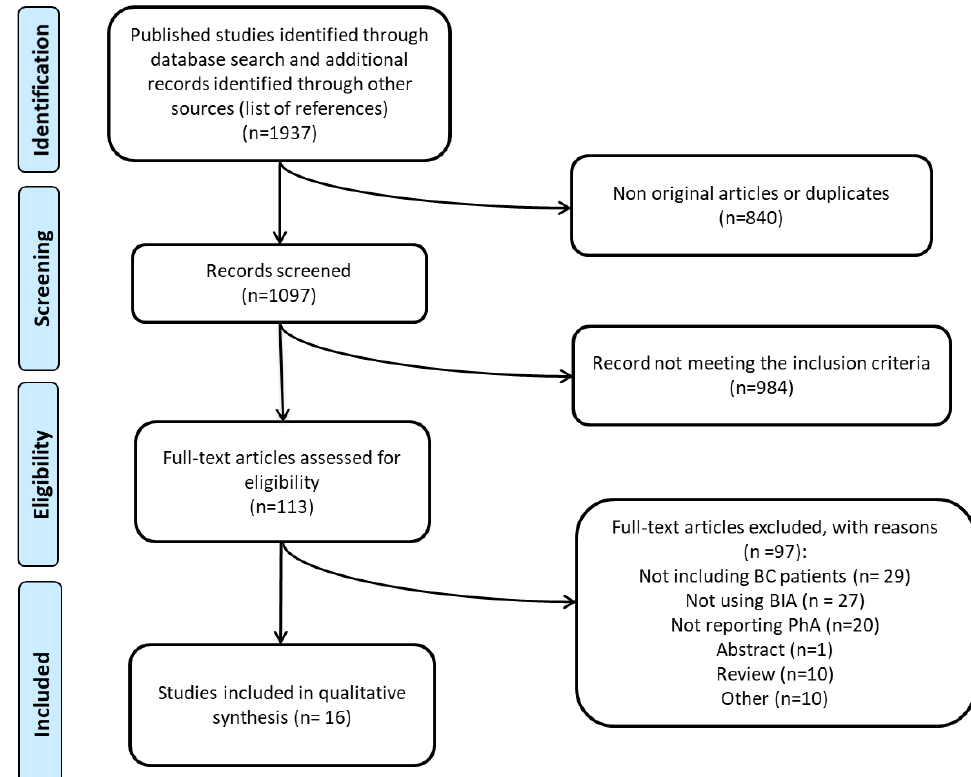
Figure 1. Flow diagram of the literature search process.